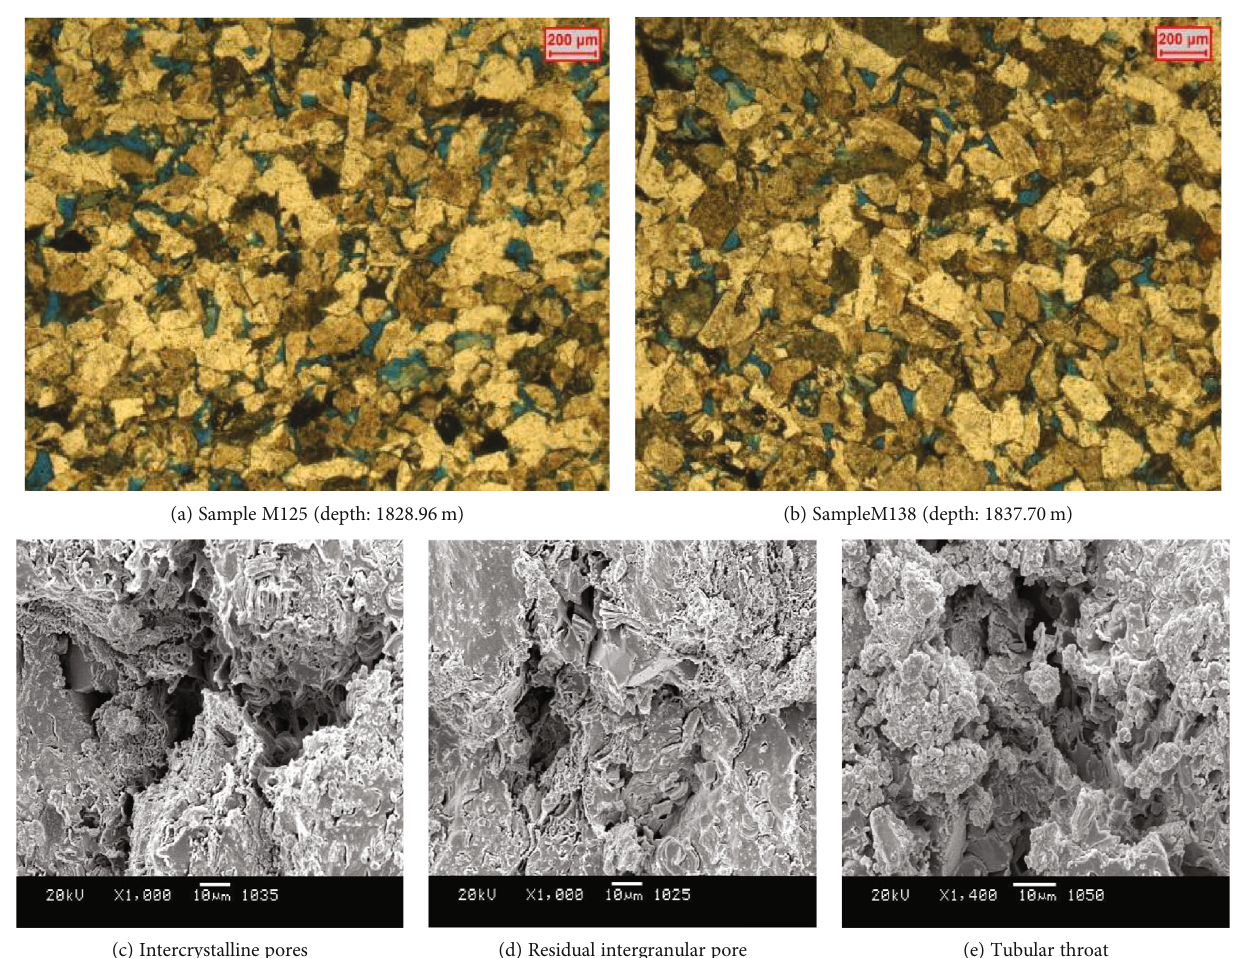
Figure 1: Images of pore structure using polarizing microscopy and scanning electron